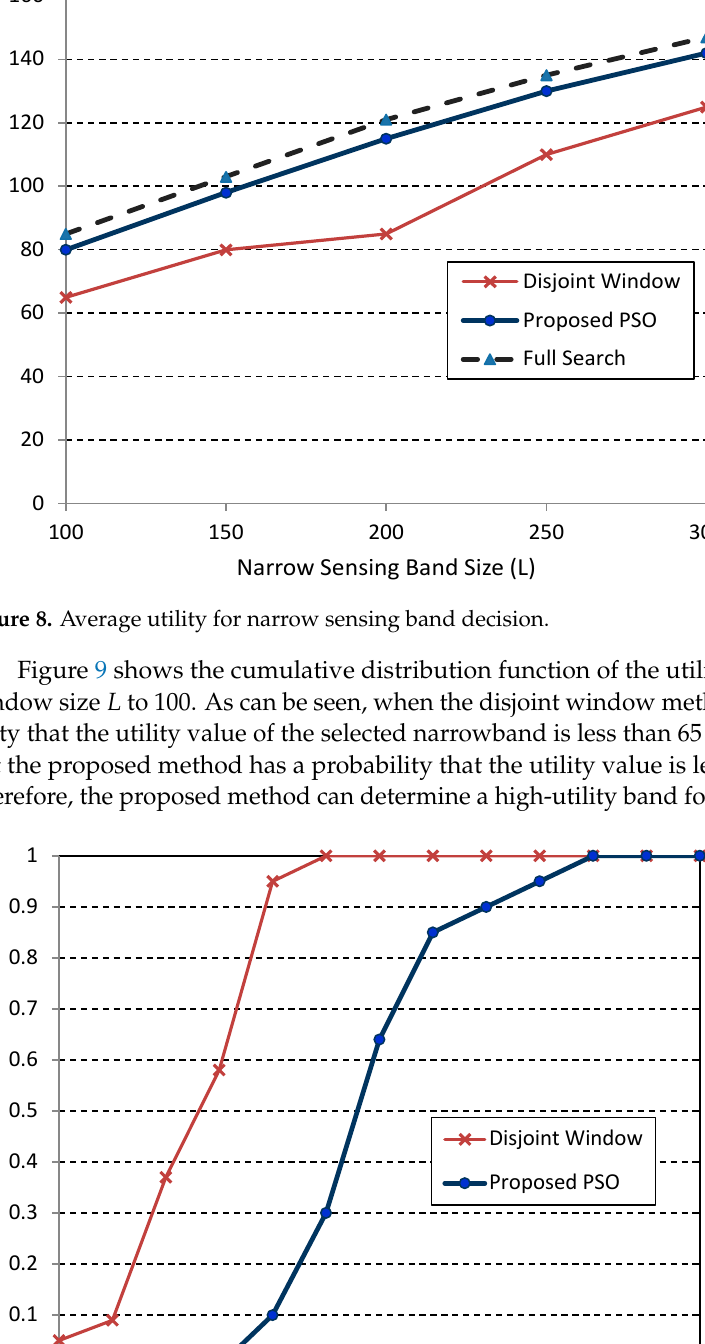
Figure 10. Average lifetime of a cluster.